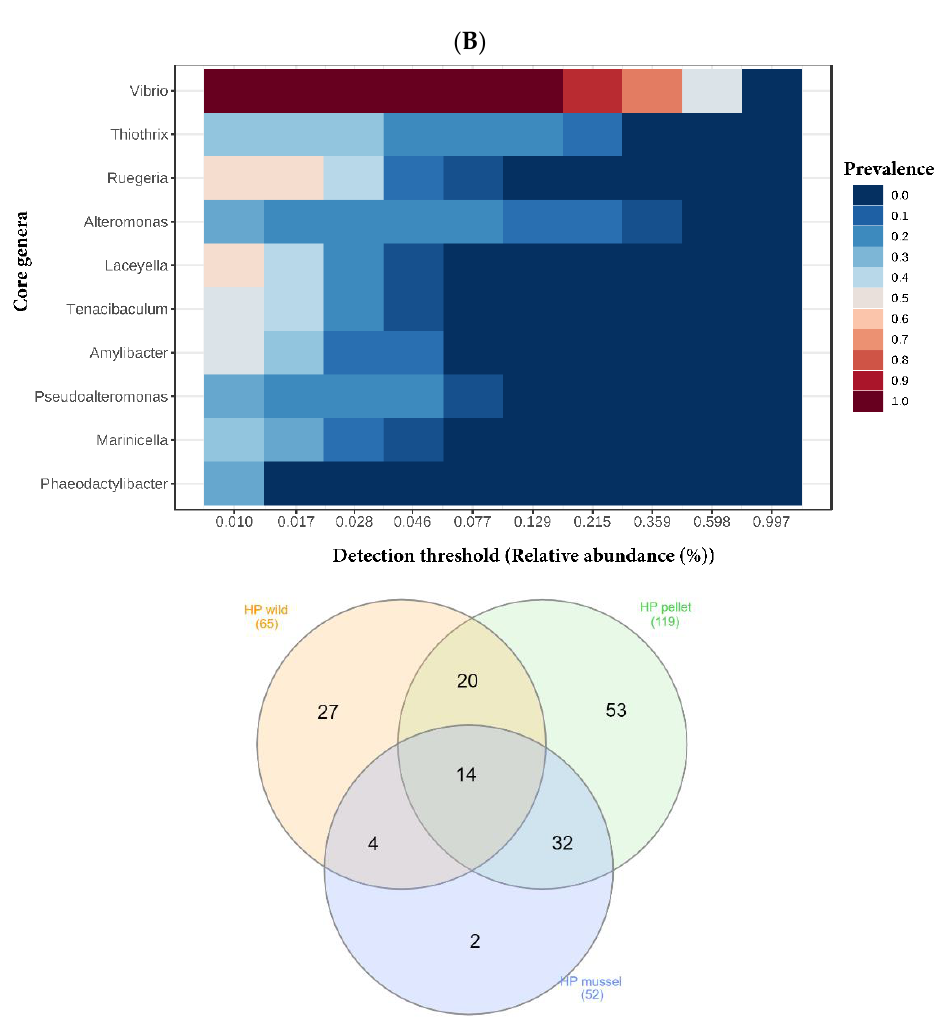
Figure 4. Core microbiota and Venn diagrams of bacterial genera in the ( A ) hindgut ( n = 15) and ( B ) hepatopancreas ( n = 15) of P. ornatus samples. Core microbiota heatmaps are colour coded, indicating the fraction of samples (prevalence) where each core genera (y-axis) is found at the relative abundance threshold shown on the x-axis.